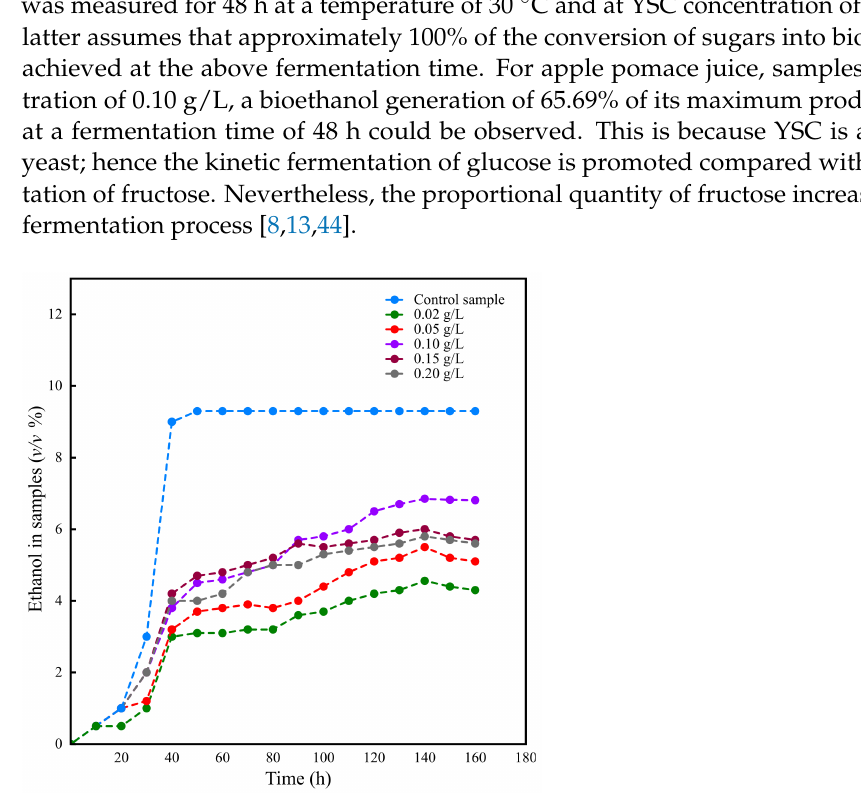
Figure 4. Quantification of bioethanol in the control sample and pomace juice samples, using YSC at a stirring speed of 100 rpm and temperature of 30 ◦